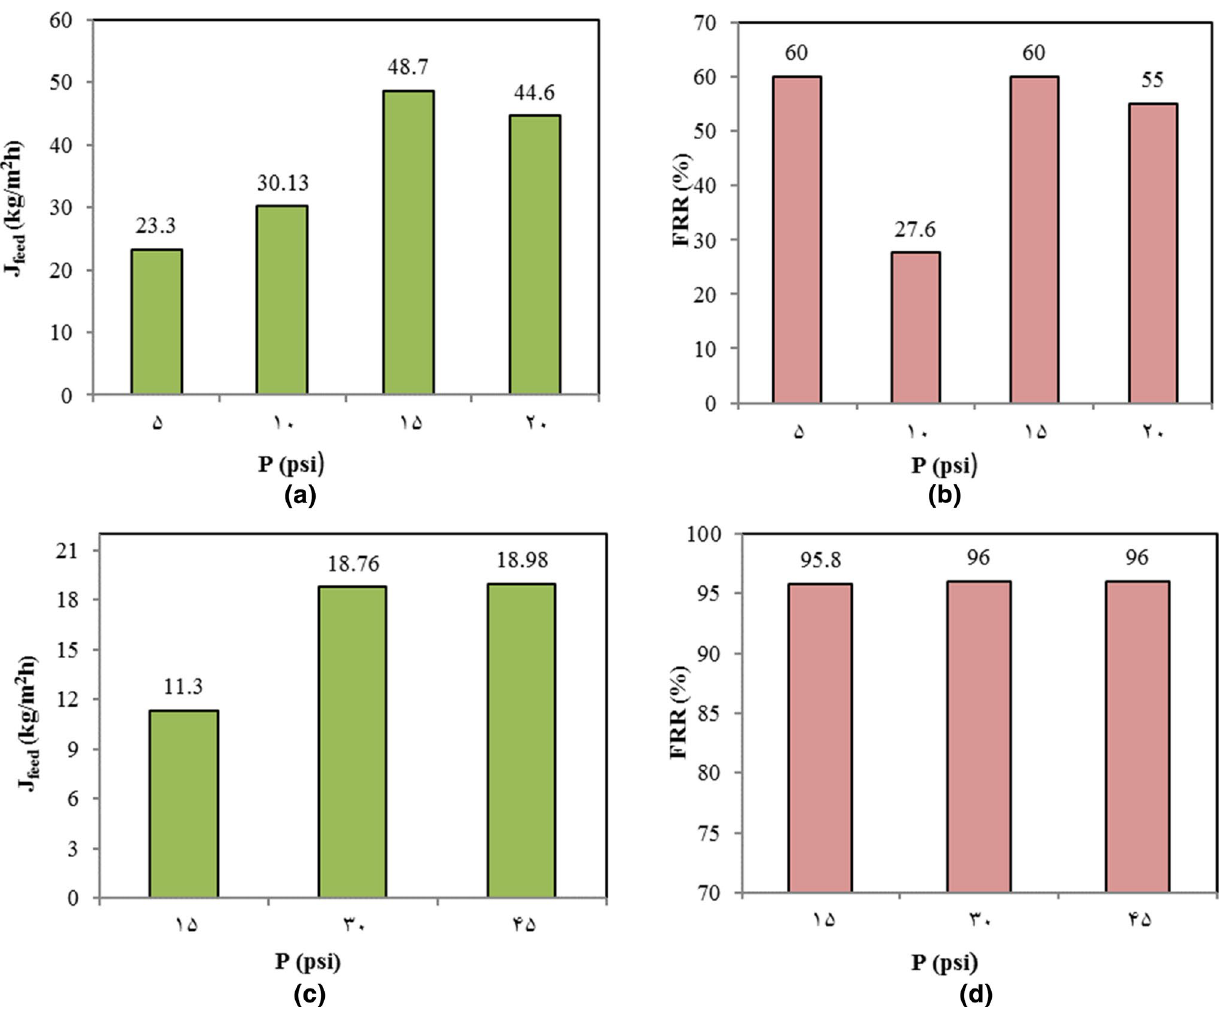
Fig. 7 J Feed ( a ) and FRR ( b ) measured for MF membrane and ple fruit juice wastewater (HRT = 8